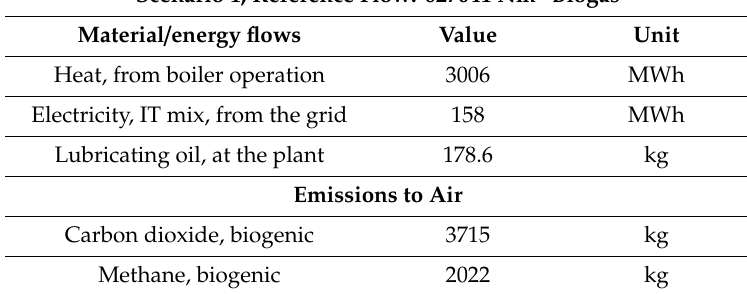
Table 10. The operational phase of the anaerobic digester (primary data from data collection at the WWTP